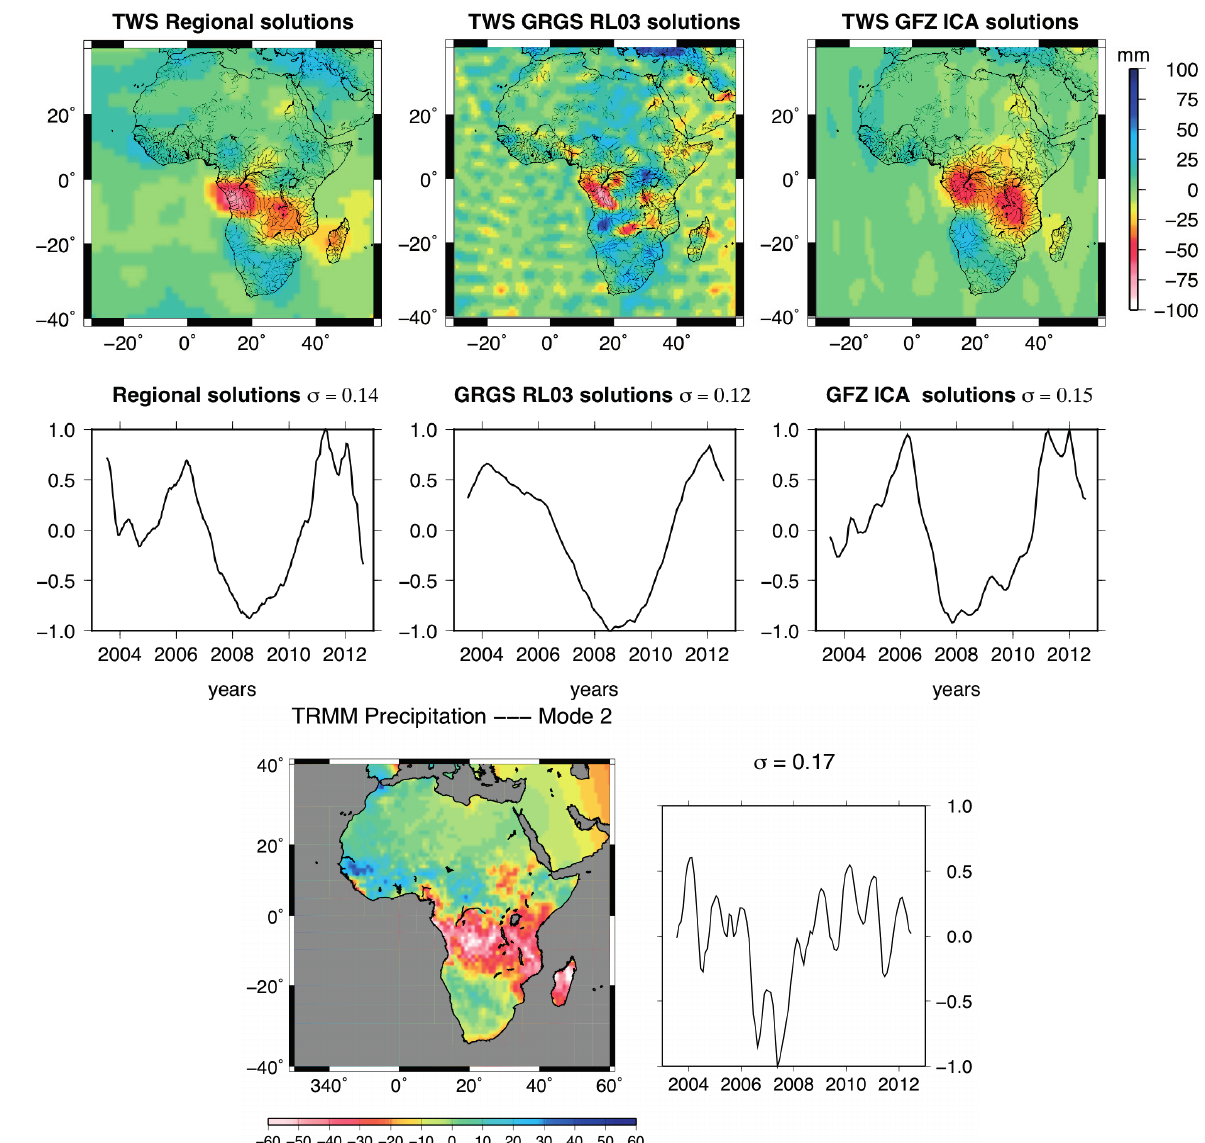
Figure 8. Second spatial ( top ) and temporal ( bottom ) modes of the PCA of the regional, global GRGS and 400-km ICA GRACE solutions. Units are mm